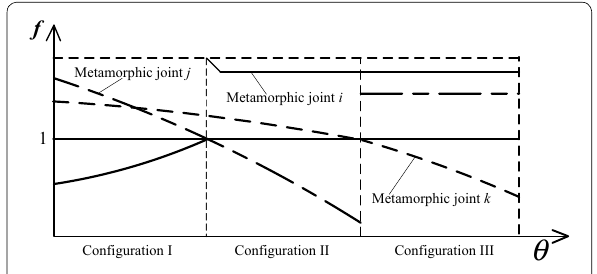
Figure 2 Equivalent resistance gradient sketch of a 3-DOF metamorphic